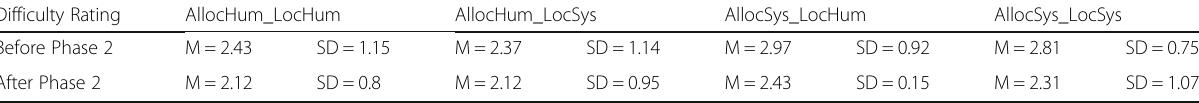
Table 7 Average score of task difficulty across groups at different stages (before and after) in Phase 2 Difficulty Rating